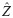
Z-scores for intrasession differences in coherence.In each subject, the recording session was divided into two epochs for which separate 15-30Hz coherence values were calculated. Single-subject Z-scores quantify the difference between both coherence values in each individual and their distribution is shown by the stairstep curves; under the null hypothesis, they should follow a standard normal distribution (blue curve). The mean compound Z-score for all subjects (Z^; vertical dotted lines) was not significant in any muscle pair (PZ; blue box showing range of ±1.96). However, in all muscle pairs the variance of individual Z-scores (Var) was significantly greater than unity as estimated by Monte-Carlo simulations (PMC).